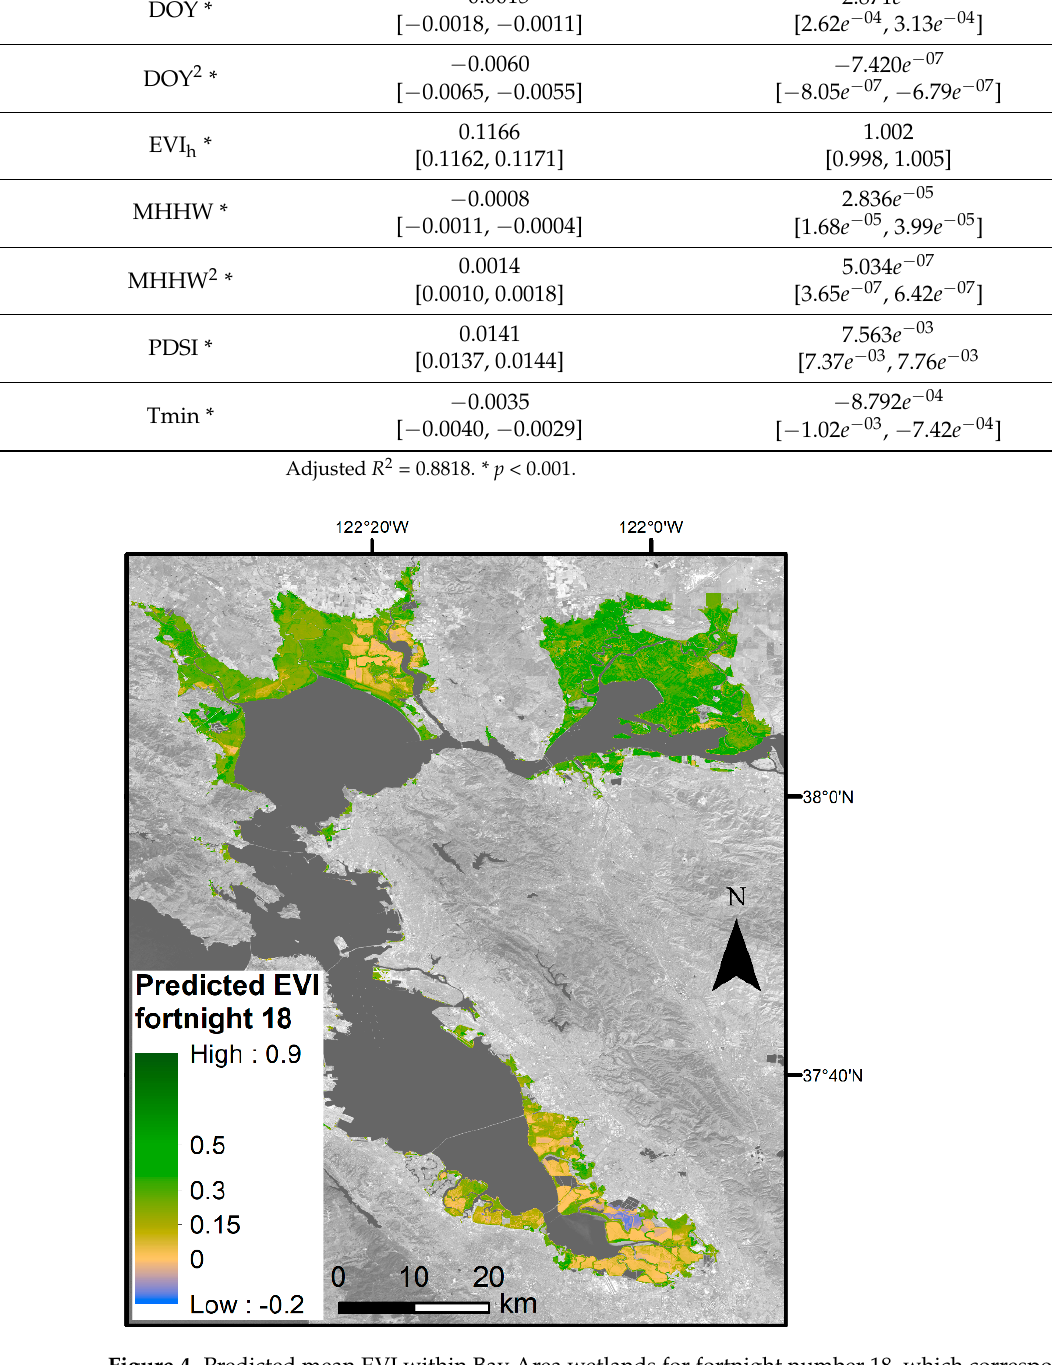
Figure 4. Predicted mean EVI within Bay Area wetlands for fortnight number 18, which corresponds to the fortnight Scheme 26. 2019. Blue areas are likely flooded or not vegetated. Yellow areas are less vegetated and, as the color Table 8. band 7 (SWIR 2), U.S. Geological Survey.